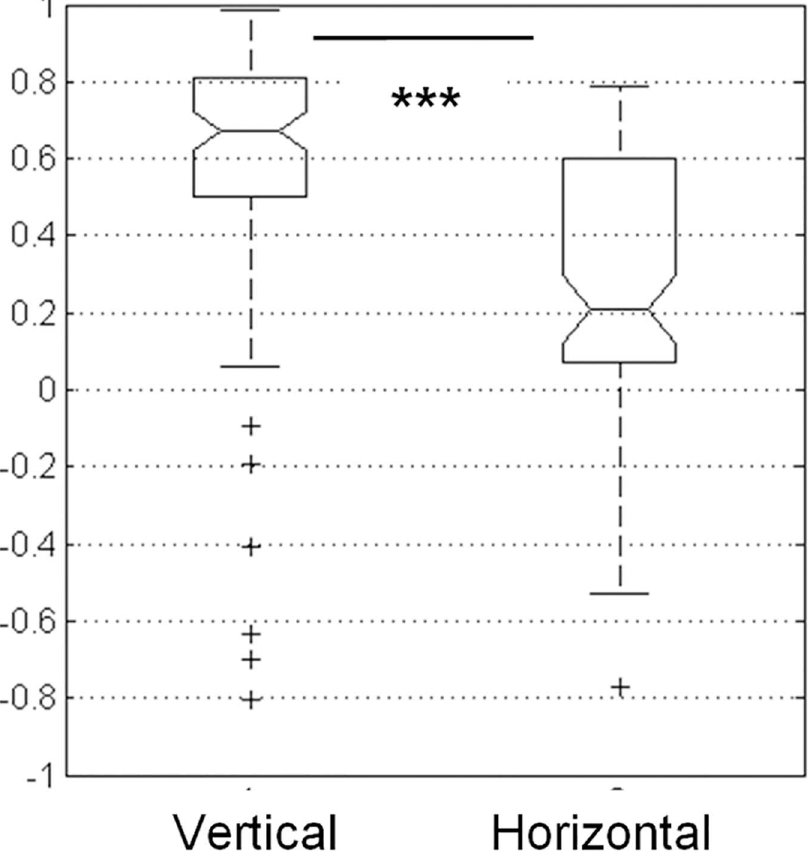
Fig 5. Vertical effect. averageof participants’s agreement for the vertical component(modulationof upper facial height) and the horizonthal component (modulationof the bizygomaticwidth). Sign test showeda strong significantdifference p < 7.78 x 10 − 14